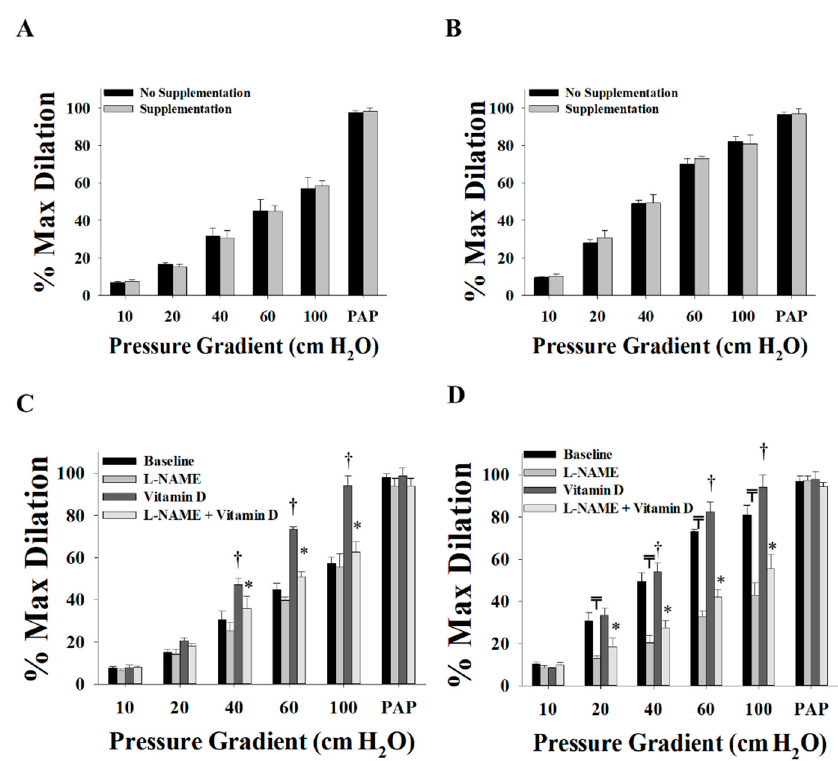
Figure 5. Effect of vitamin-D supplementation prior to surgery on FID in adipose tissue resistance arterioles collected on the day of surgery. FID measurements corresponding to intraluminal pressure gradients of 10 – 100 cm H 2 O in VAT arterioles ( A ) and SAT arterioles ( B ) from subjects who administered vitamin-D supplements before surgery ( n = 4) and subjects who did not ( n = 11). Effect of L-NAME and vitamin-D incubation on FID in VAT arterioles ( C ) and SAT arterioles ( D ) from subjects who administered vitamin-D supplements before surgery ( n = 4). All measurements are presented as means ± standard error (SE); ₸ p < 0.05 comparing L-NAME with baseline, † p < 0.05 comparing vitamin D with baseline, and * p < 0.05 comparing L-NAME + vitamin D with vitamin D alone.